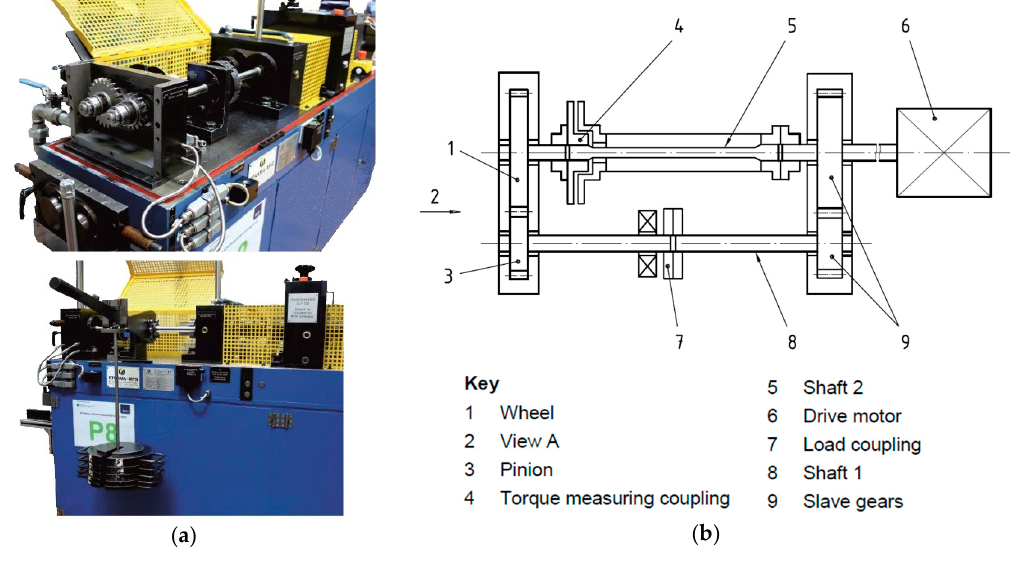
Figure 1. FZG gear test rig: ( a ) photos; ( b ) schematic drawings.